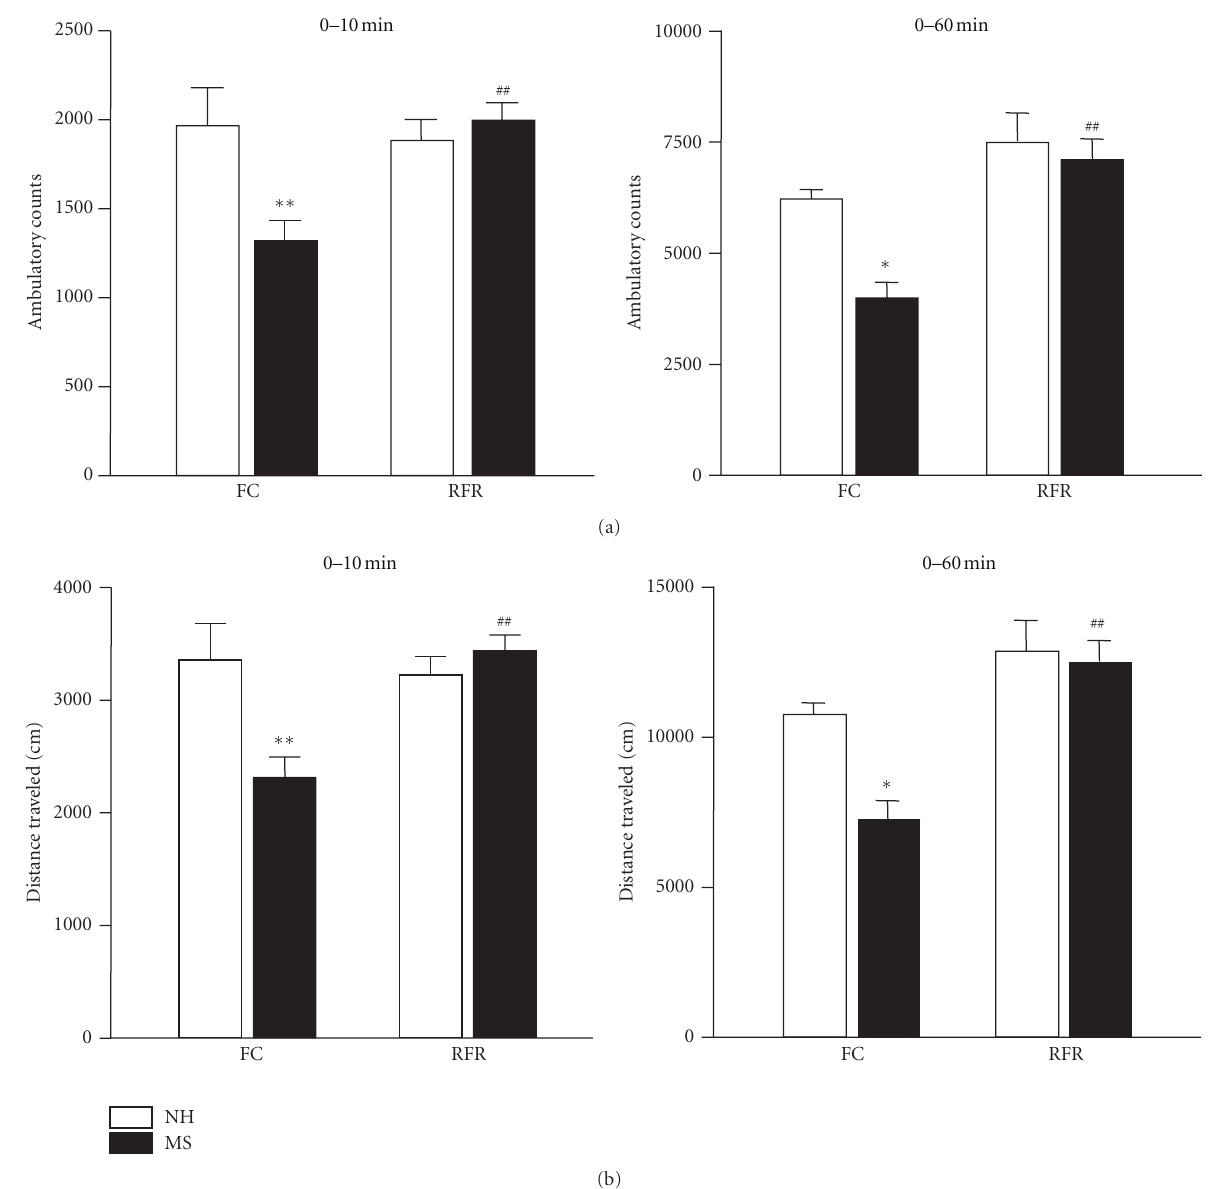
Figure 1: Ambulatory counts (a) and travel distance (b) of NH and MS rats, which were recorded consecutively at every 5 min during 60 min of test period. NH/RFR and MS/RFR rats and their age-matching free fed control rats (NH/FC and MS/FC) were subjected to the ambulatory test on PND 54 at the end of the 13th refeeding session. ∗ P < 0.05, ∗∗ P < 0.01 versus NH/FC, ## P < 0.01 versus MS/FC, NH: nonhandled, MS: maternal separation, FC: free fed control, RFR: repeated fasting/refeeding, min: minutes. Data are presented as means ±